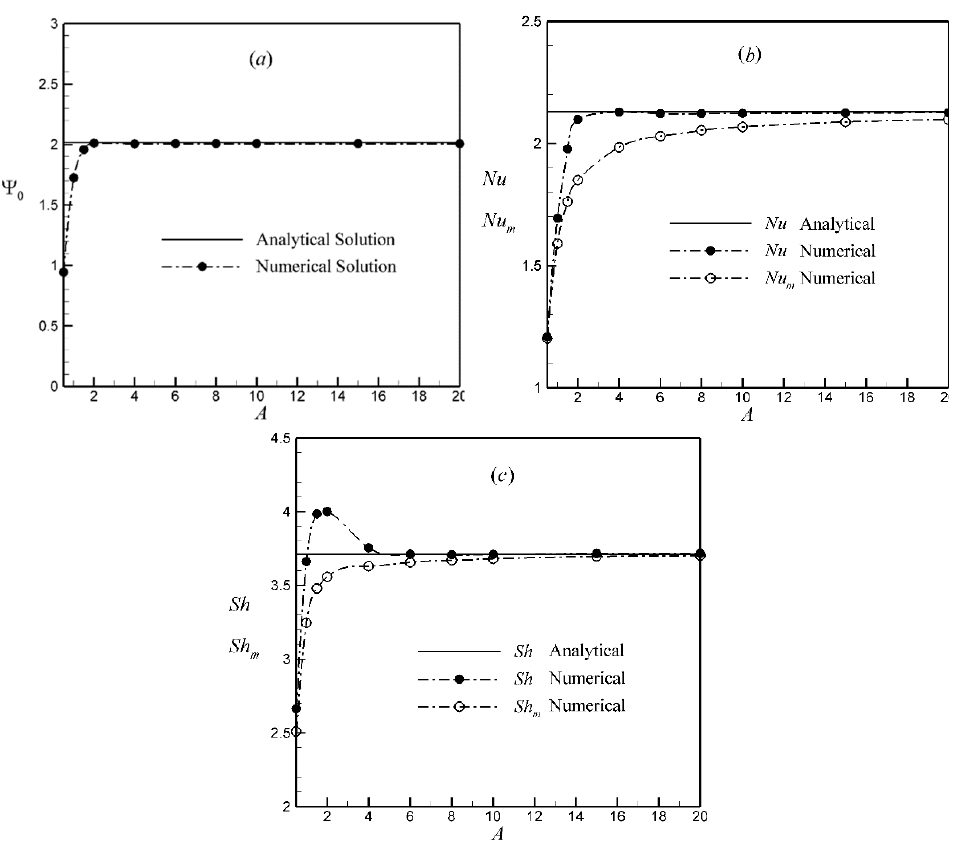
Figure 4. Enclosure aspect ratio effect on ( a ) the flow intensity, ( b ) and the heat, and ( c ) mass transfer rates for: R T = 50, Le = 5, ε = 1 and D u = S r =